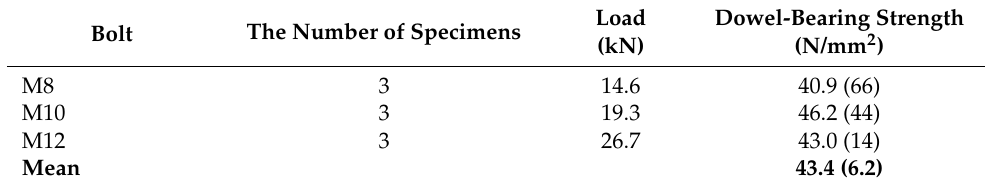
Table 8. The result of the dowel-bearing